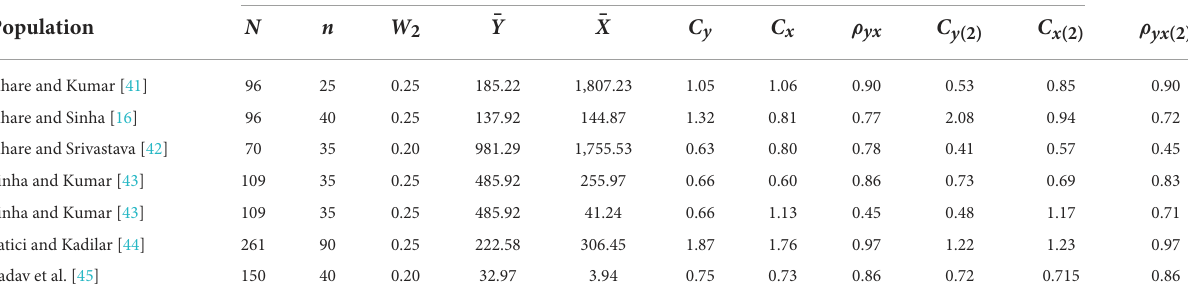
TABLE 1 Parameters of different populations under consideration.